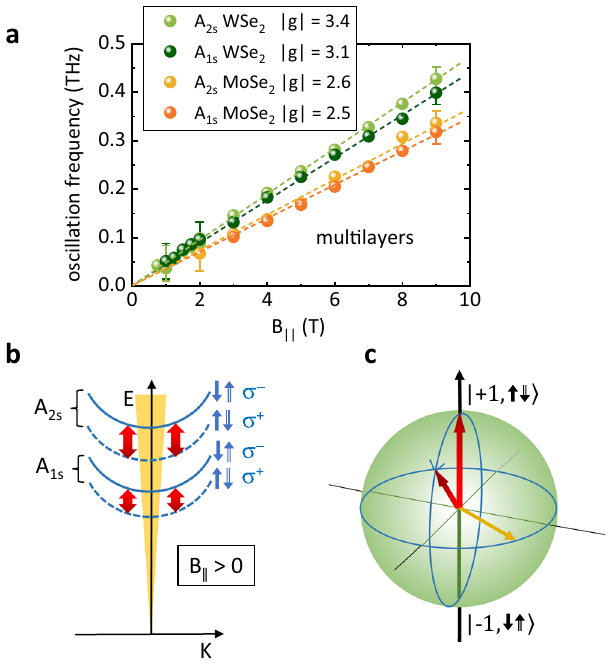
Fig.3|Extractedin-plane g factors,andproposedmechanism.a Experimentally detected oscillation frequencies for A 1s and A 2s intralayer excitons (orange and yellow solid bullets) in MoSe 2 , and, A 1s and A 2s intralayer excitons (dark green and lightgreensolidbullets)inWSe 2 multilayersamplesversusin-planemagnetic fi eld. Exemplary error bars for low and high fi elds are indicated. The extracted absolute values ∣ g ∥ ∣ are given in the legend. The experimental error margins are about±0.2. b Energyversuscenter-of-massmomentum K dispersionof intralayerAexcitonsat B ∥ >0 ina multilayer.For the excitons, the z component of the spin of the electron is symbolized by asmallarrow with a single line, while the holespin is indicated by an arrow with a double line. Energy splittings of the excitons due to fi nite g ∥ are taken into account. The red double arrows should symbolize the coherent momentum-allowed oscillation between adjacent layers. c Representation of the pseudospinrotationonaBlochsphere.Thenorthpolecorrespondsto τ =+1,while thesouthpolerepresentsthe τ = − 1state.Theorangearrowwould correspondtoa system, excited with linearly-polarized